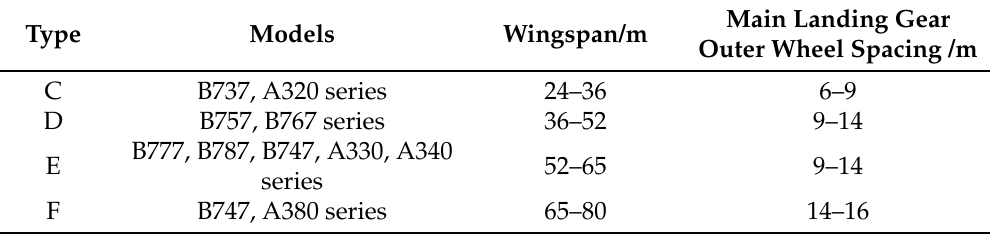
Table 1. Aircraft model classifications